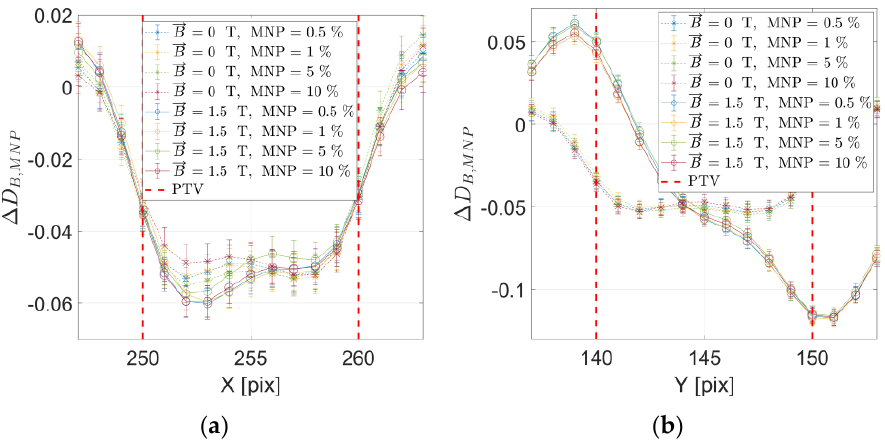
Figure 5. Dose distribution vertical ( a ) and horizontal ( b ) profiles for the transversal plane reporting all configurations, varying FeNP concentration and magnetic field (perpendicular to incident X- ray beam) presence. Vertical red dashed lines delimit the MNP-infused target (PTV). Reported uncertainties correspond to 1 standard deviation.